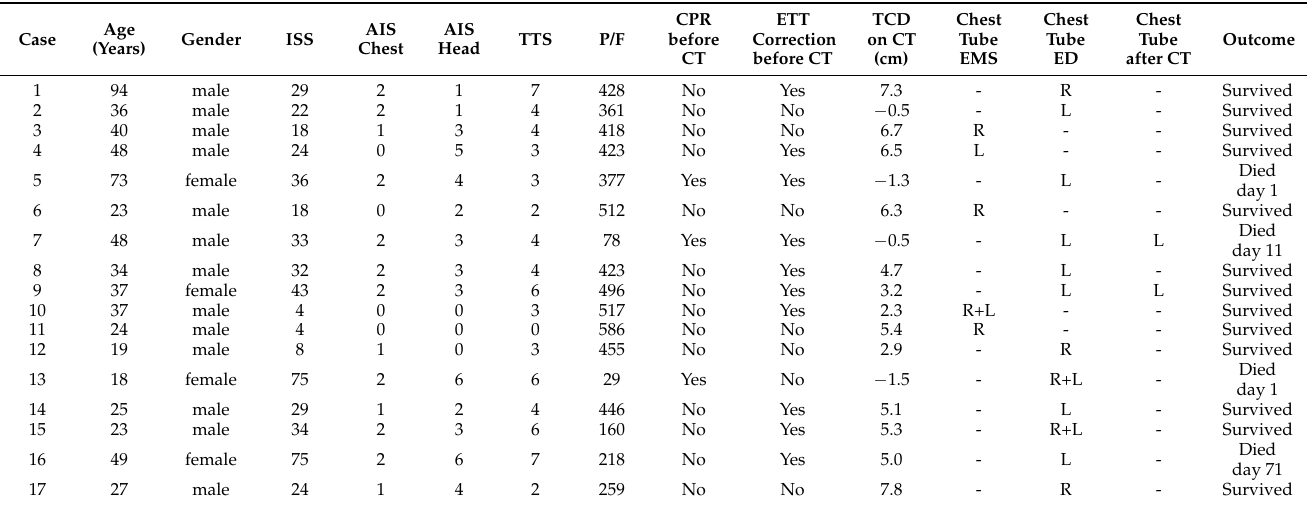
Table 3. Individual characteristics of patients with chest tube placement before computed tomography and minor thoracic injuries.